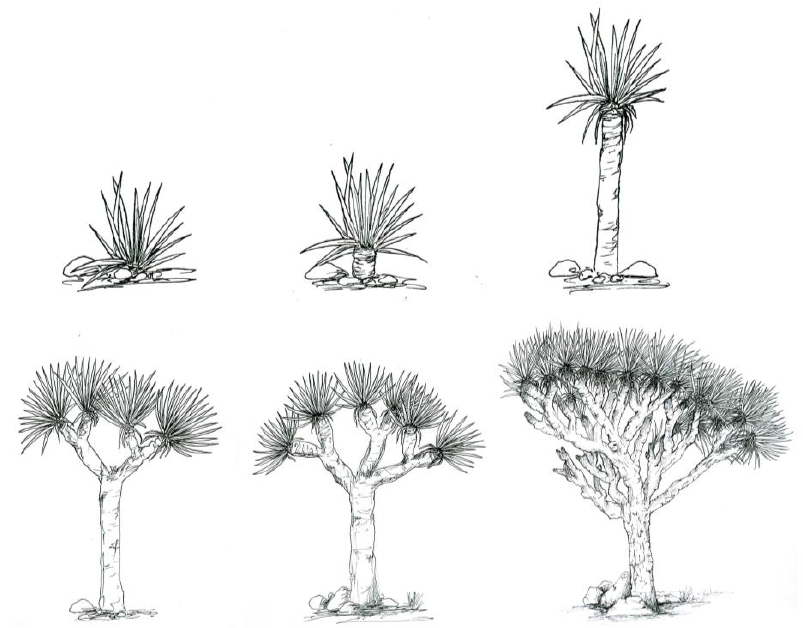
Figure 1. Schematic diagram of juvenile and mature trees according to Maděra et al. [30]. Trees in the ( top ) row are classified as juvenile; they have a single rosette and no trunk or a single rosette on an unbranched trunk. Trees in the ( bottom ) row are classified as mature; they possess at least one lateral branch.